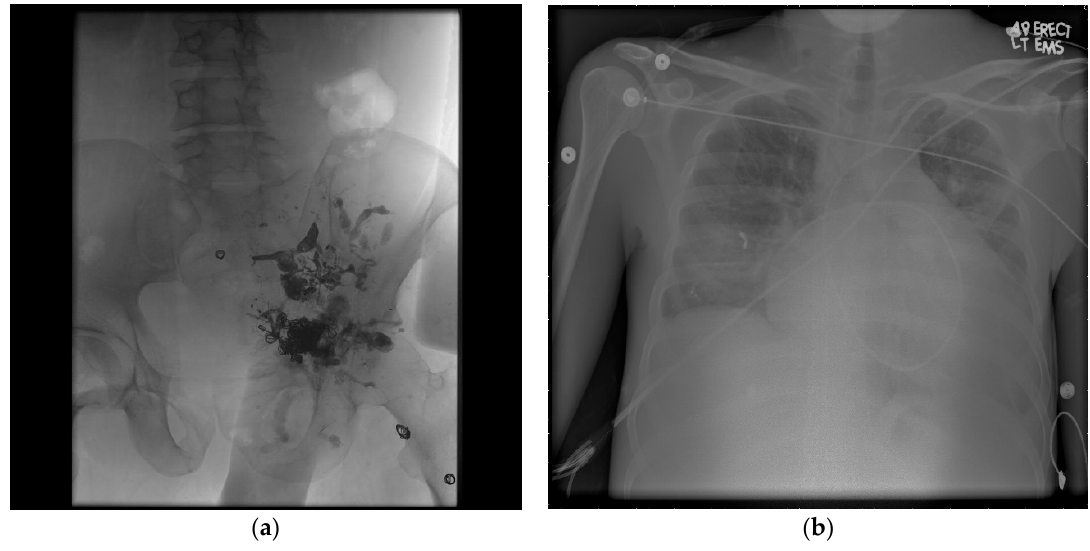
Figure 1. Schobinger Stage IV arteriovenous malformations (AVM). ( a ) The post-treatment angiogram shows the extent of a dilated hypogastric venous system due to drainage from the nidus and presence of a pelvic AVM with multiple outflowing veins as well as one particularly large flowing vein. The AVM has been treated from the venous side with coils and from the arterial side with a liquid embolic agent, indicative of a possible Yakes IIb/IIIb angiographic type. ( b ) A chest X-ray shows that the patient also presented with cardiomegaly and high-output cardiac failure due to stress on the venous circulation.